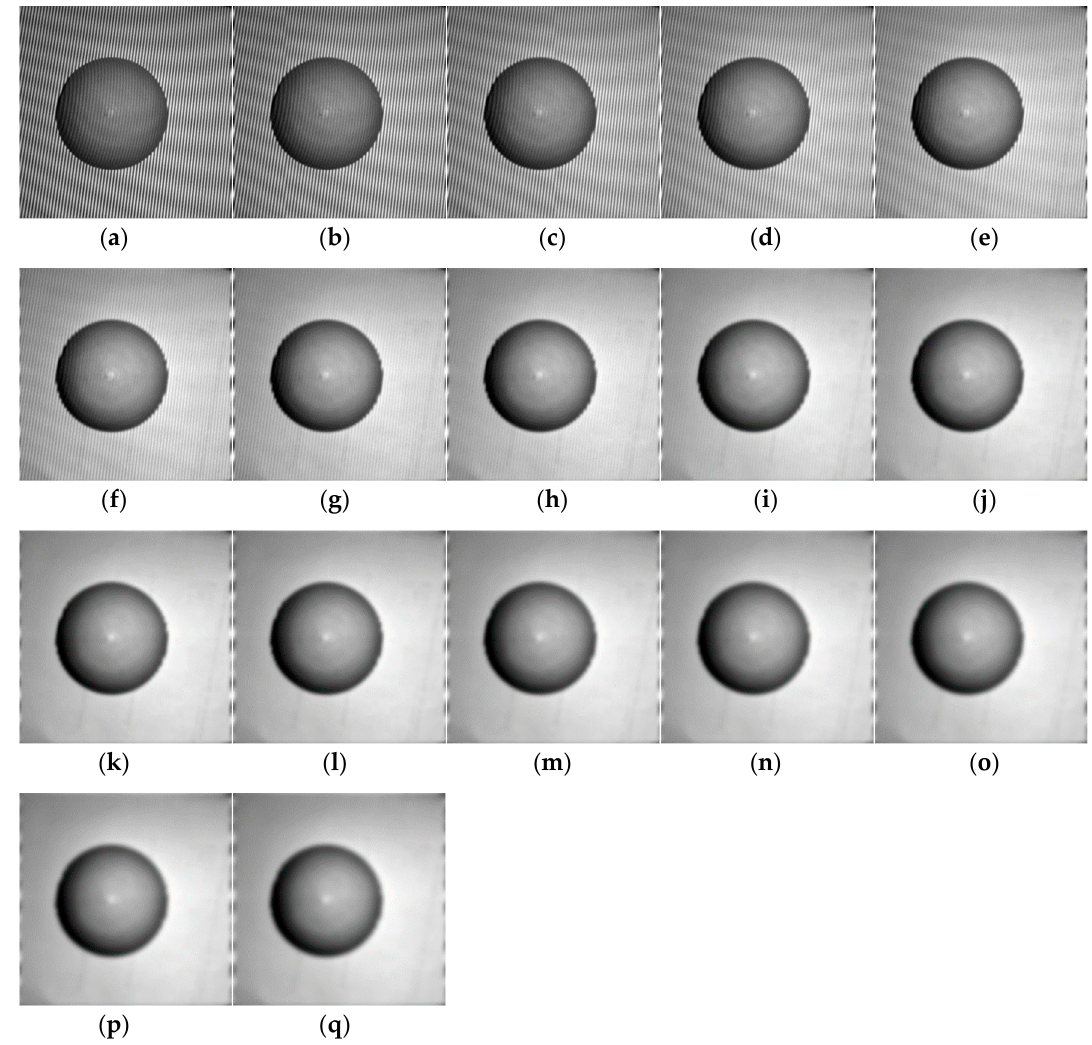
Figure A3. The decomposed background of Figure 3a by Fourier transform method with different parameter values. ( a – q ) are the decomposed background by Fourier transform method with 1th to 17th of filtering window sizes of [4:1:20], respectively.